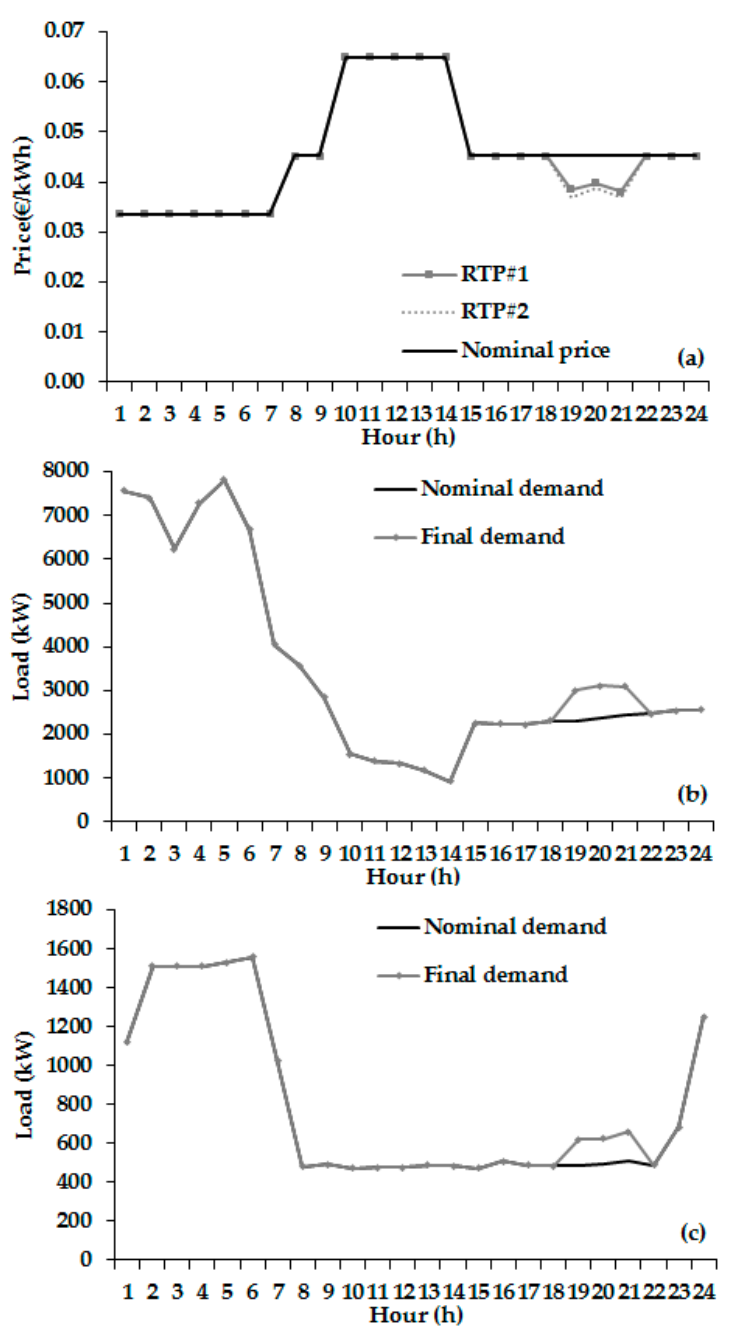
Figure 21. VF objective results with exponential DR model: ( a ) Nominal price and RTP; ( b ) nominal and final demand of consumer 1 and ( c ) nominal and final demand of consumer 2.